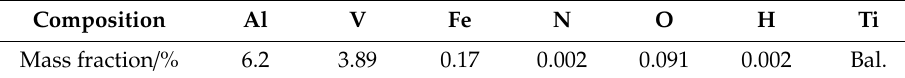
Table 1. Chemical composition of Ti64 powder.